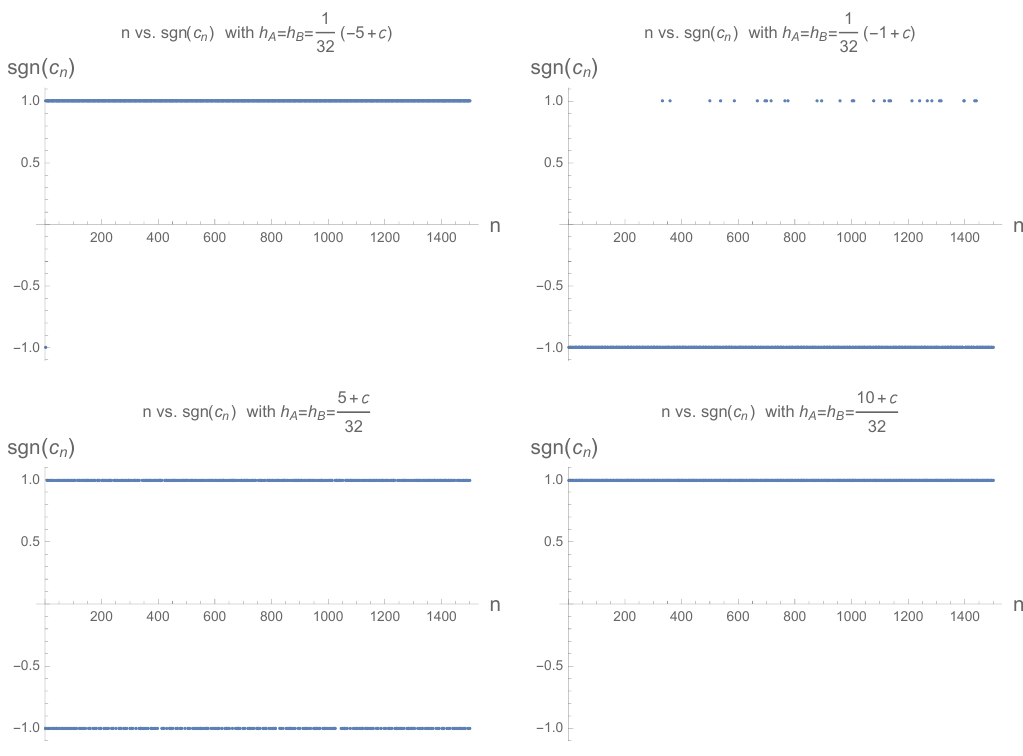
Figure 2 . The n -dependence of sgn ( c n ) for various h O = c − 5